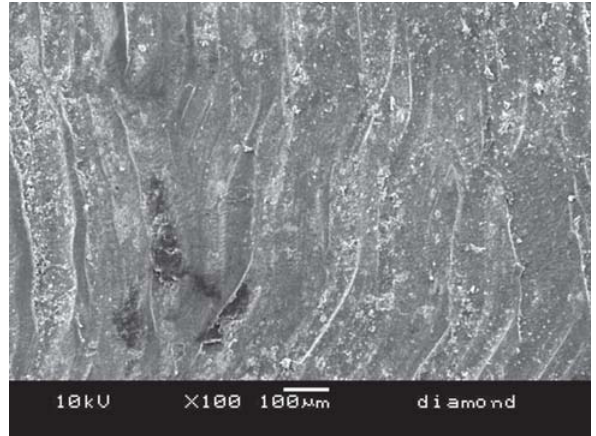
FIGURE 4- Micrograph of root surface produced by sonic instrumentation with diamond-coated sonic instrument tip. Note the irregular aspect caused by diamond